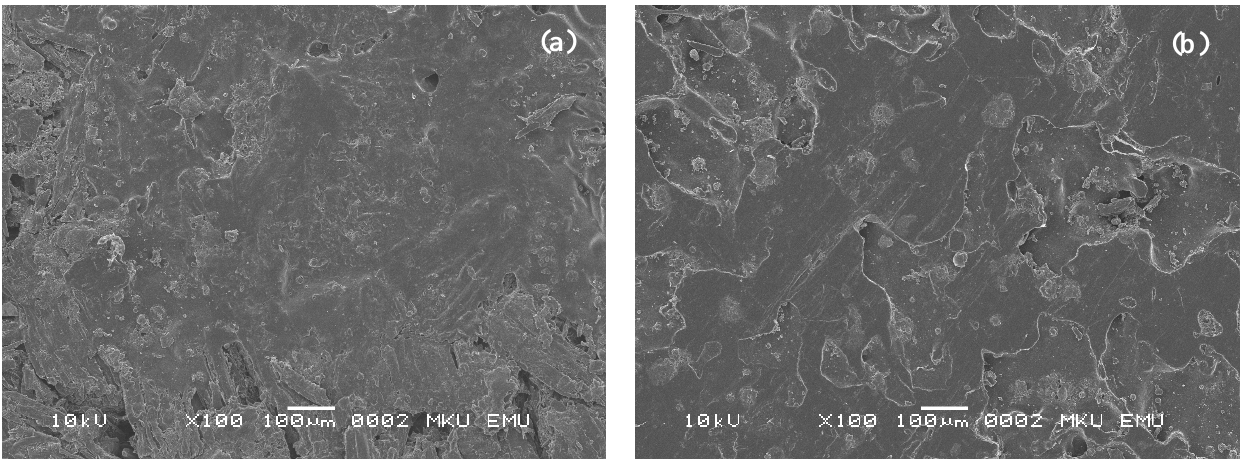
Figure 2. SEM micrographs of (a) 72 hours water soaked unmodified and (b) MAPE modified HDPE based wood plastic